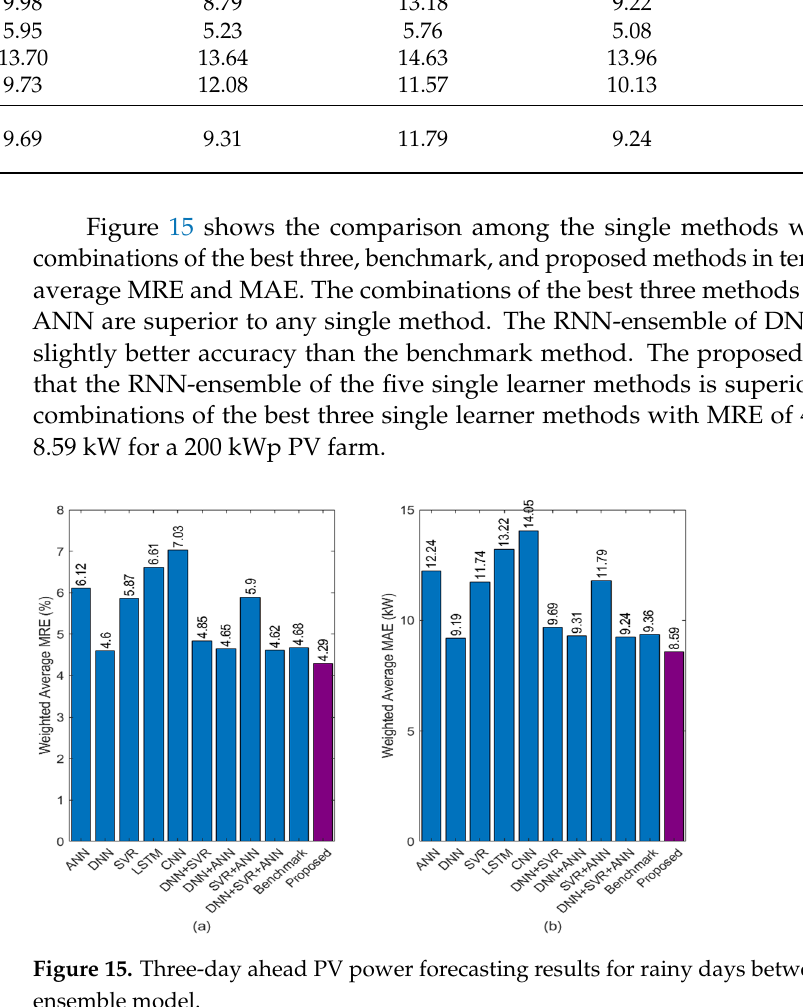
Table 10. The improvement of the proposed method compared to the single, combination, and benchmark methods. Methods